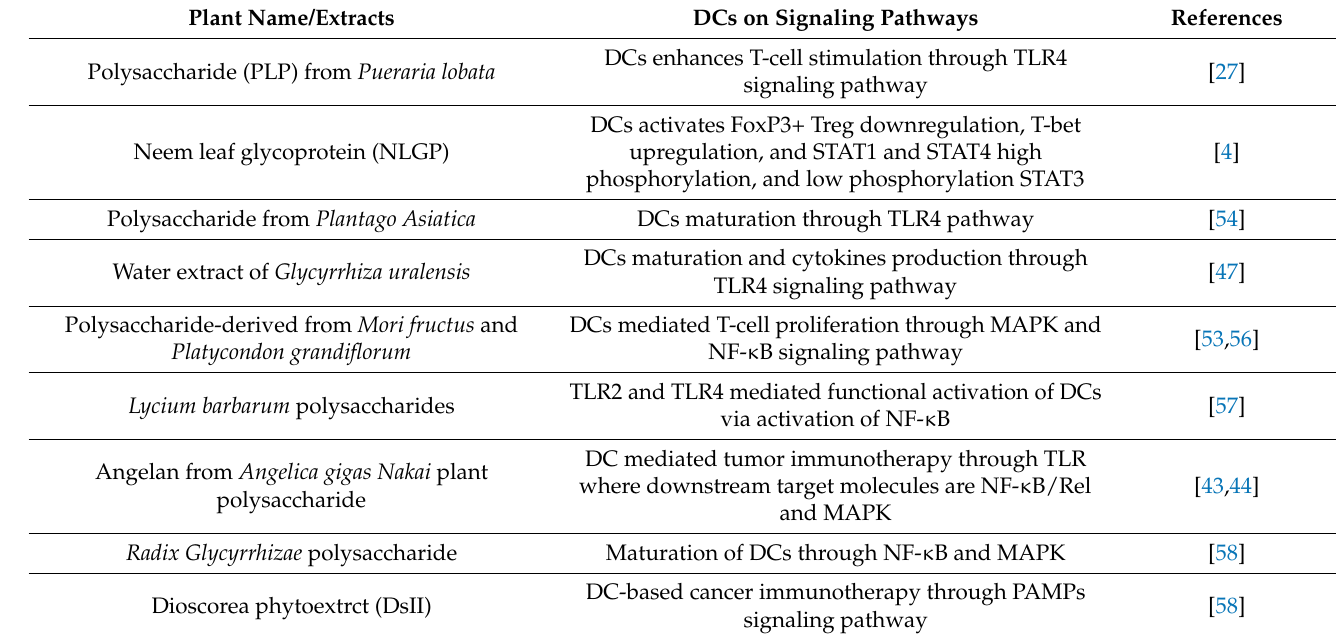
Table 4. Plant extracts pulsed DCs on various signaling pathways in anti-tumor